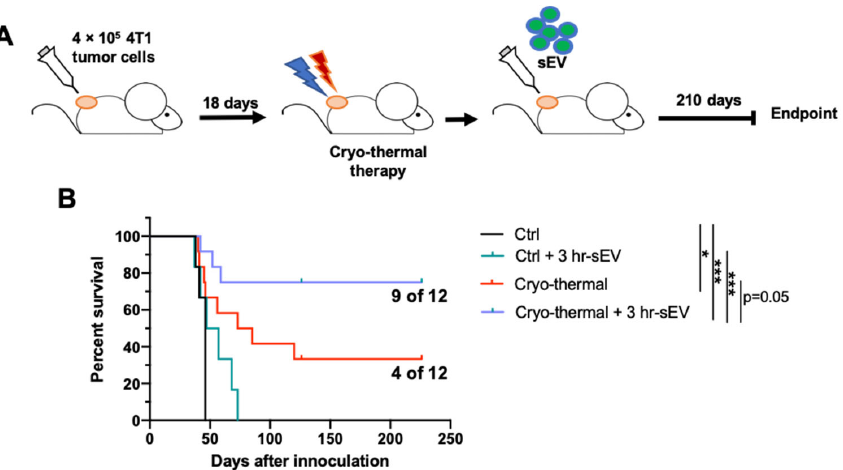
Figure 8. Supplementation with sEVs released after cryo ‐ thermal therapy prolonged the survival of cryo ‐ thermal therapy ‐ treated mice. ( A ) Schematic of experimental design; 4 × 10 5 4T1 cells were in ‐ of cryo-thermal therapy-treated mice. ( A ) Schematic of experimental design; 4 × 10 5 4T1 cells were jected subcutaneously into the right flank. Mice were treated with cryo ‐ thermal therapy 18 days injected subcutaneously into the right flank. Mice were treated with cryo-thermal therapy 18 days after tumor inoculation; 50 μ g sEVs or PBS of the same volume were given to each mouse through after tumor inoculation; 50 µ g sEVs or PBS of the same volume were given to each mouse through the tail vein immediately after cryo ‐ thermal therapy. ( B ) Kaplan–Meier survival plot of the survival the tail vein immediately after cryo-thermal therapy. ( B ) Kaplan–Meier survival plot of the survival observation. Curves were compared using log ‐ rank tests. n = 6 for control and control + 3 h ‐ sEV observation. Curves were compared using log-rank tests. n = 6 for control and control + 3 h-sEV group. n = 12 for cryo ‐ thermal and cryo ‐ thermal + 3 h ‐ sEV group. * p < 0.05, *** p < 0.001. group. n = 12 for cryo-thermal and cryo-thermal + 3 h-sEV group. * p < 0.05, *** p <